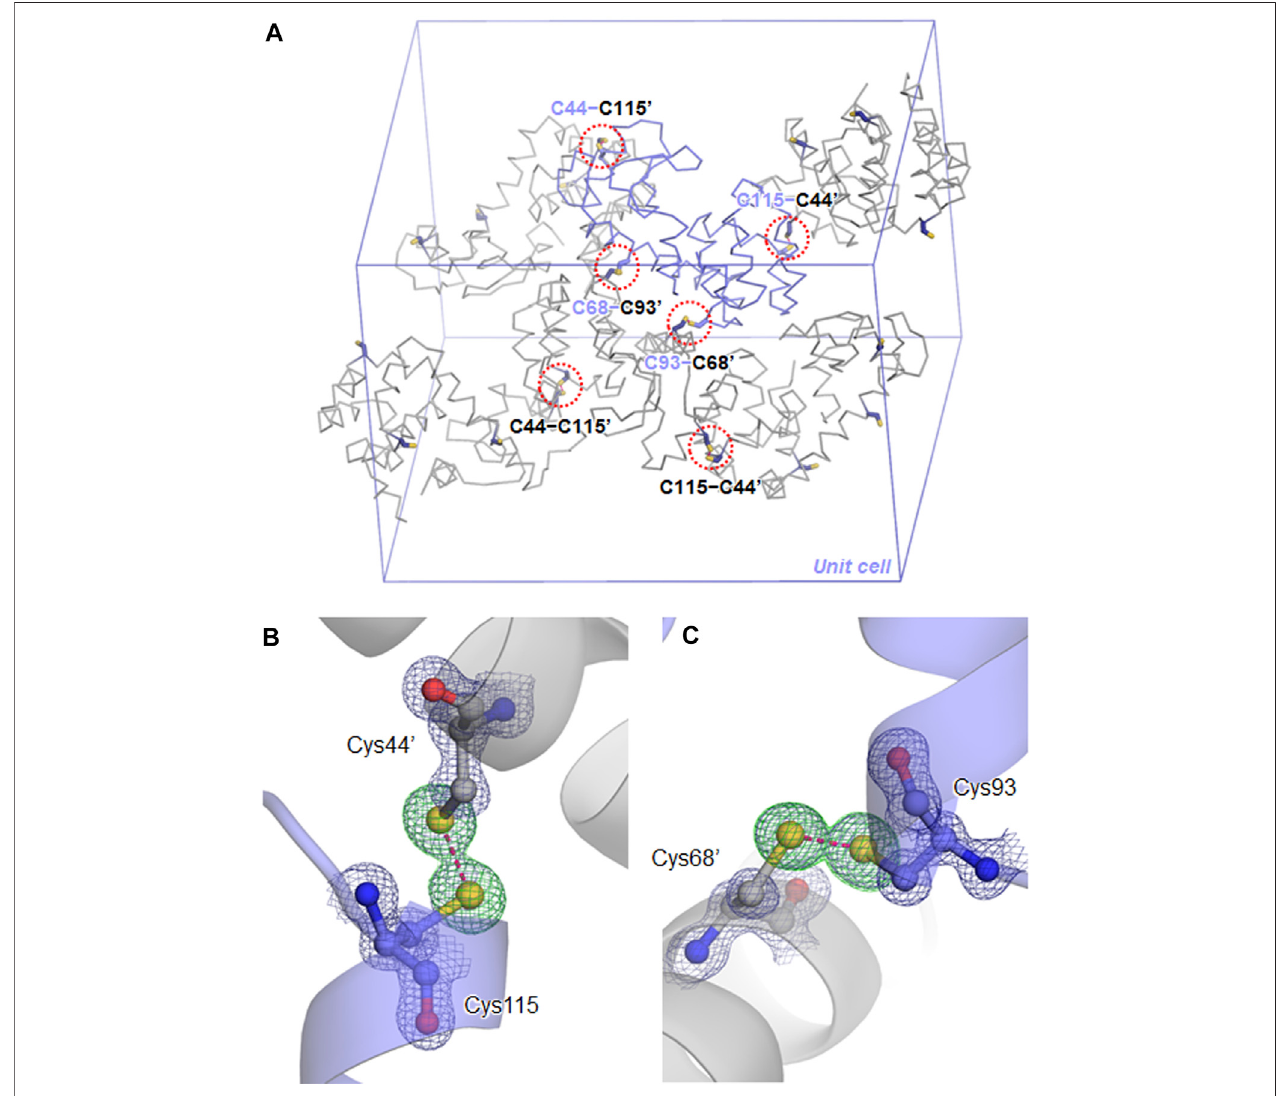
FIGURE 1 | Disul fi de cross-links in the SNAT-T4L crystal. (A) Symmetry-related molecules in the P 3 2 21 unit cell are shown in backbone representations. One independentmoleculeiscoloredinslate,andtheothersareingray.Residuesmutatedtocysteinesatthepackingcontactsareshownbysticks,wheretheprimesymbol denotesaresiduefromthesymmetry-relatedmolecule.Eachreddashedcircleindicatesthelocationsofdisul fi decross-linksintheunitcell. (B) TheC115 − C44 ’ disul fi de bond, superimposed with a 2 F o − F c electron-density map contoured at 1.5 σ (deep blue mesh). The green mesh shows a F o − F c omit electron-density map contoured at 4.0 σ , calculated for visualizing the sulfur atom positions. The disul fi de bond is depicted by a pink dashed line, with a distanceof 2.05 Å. (C) The C93 − C68 ’ disul fi de bond with a distance of 2.03 Å.